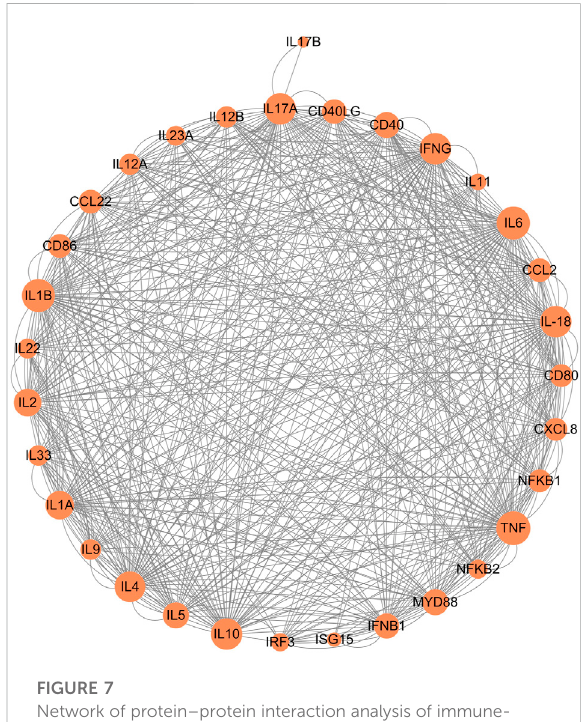
FIGURE 7 Network of protein – protein interaction analysis of immune- related